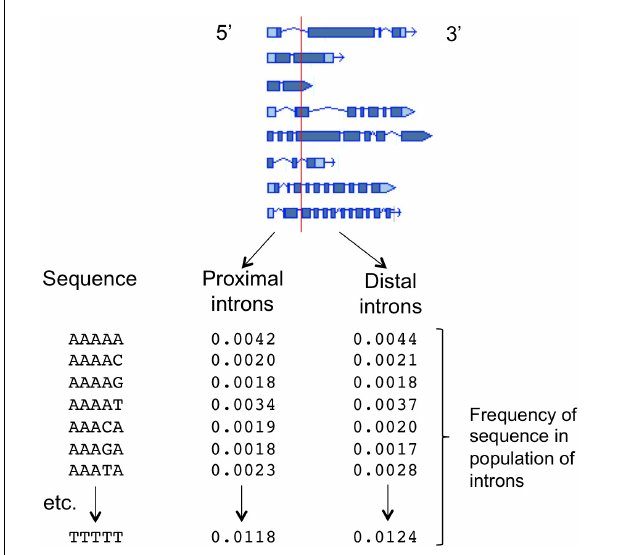
FIGURE 1 | The function of the IMEter algorithm. The sequences of the introns in a genome are computationally separated into two groups based on whether the start of the intron is less than or greater than a threshold distance from the start of transcription for that gene. For each population of intron sequences, the frequency of occurrence of all possible nucleotide words of a given length (such as the pentamers shown) is calculated. A test sequence is compared to those two profiles, generating a numerical score that reflects the degree to which that sequence more strongly resembles the profile of promoter-proximal introns. Detailed descriptions of the underlying calculations, and the refinements added in different versions of the IMEter, can be found in Rose et al. (2008) and Parra et al.